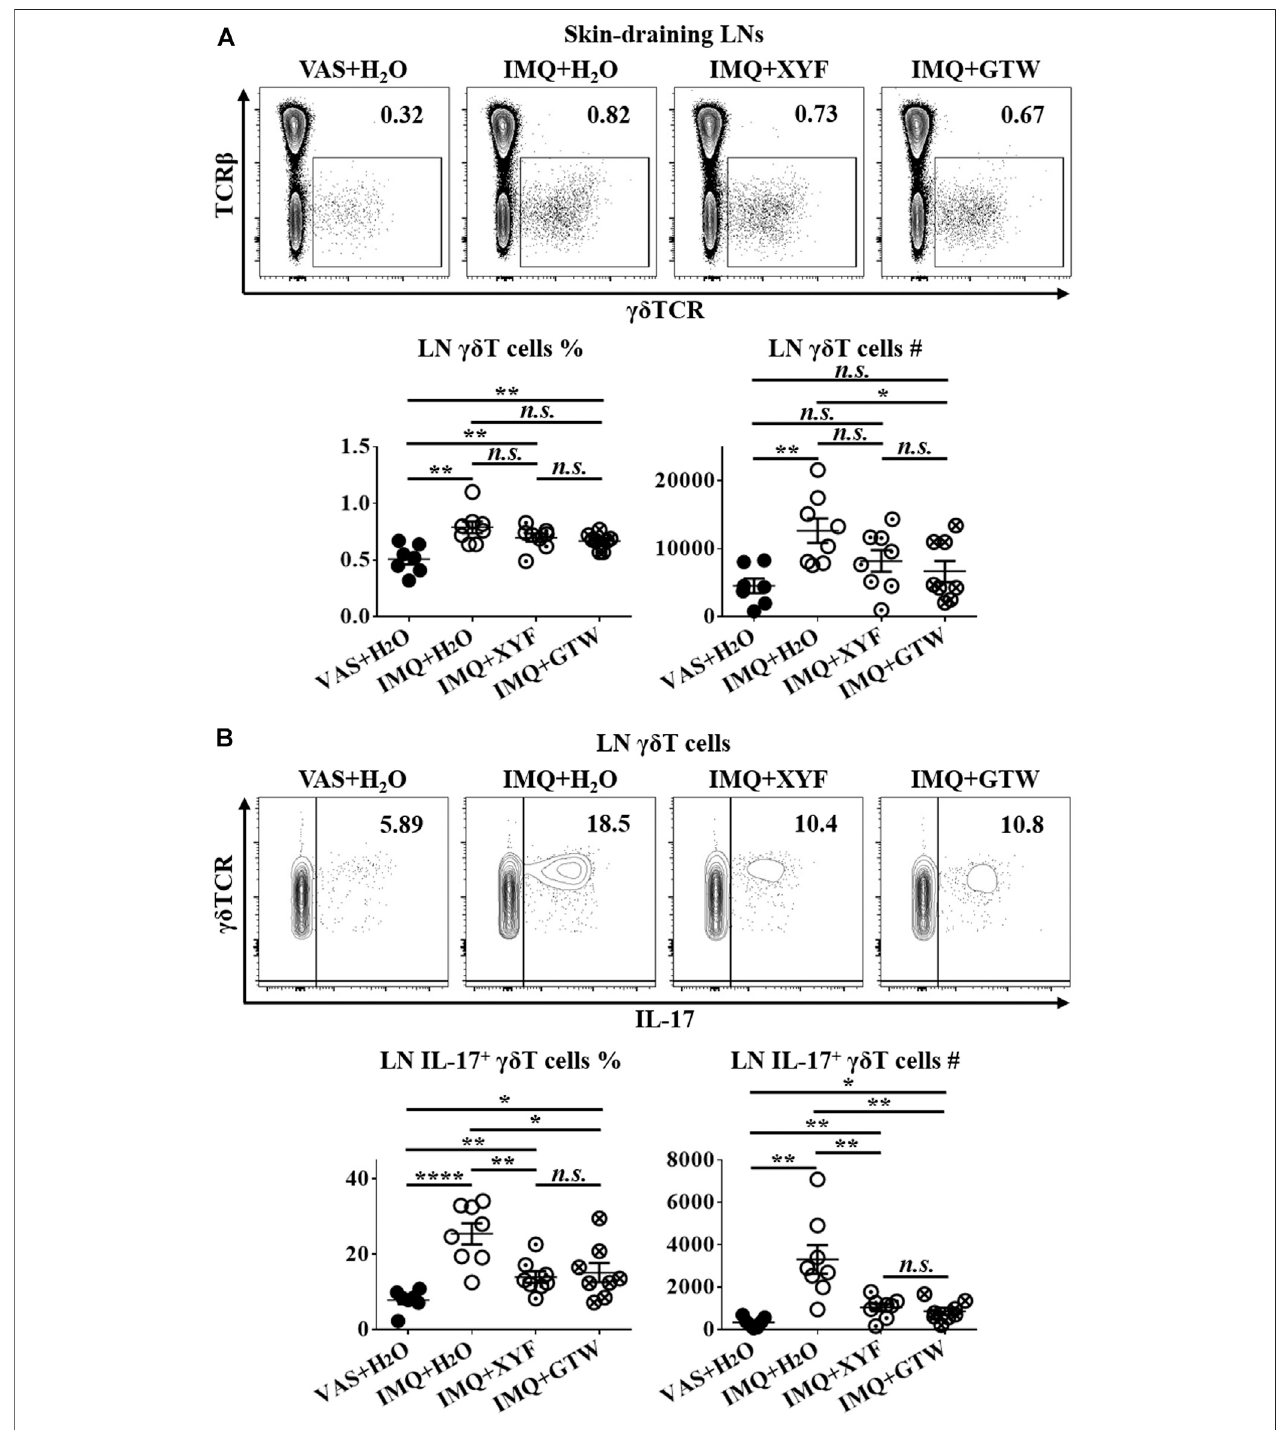
FIGURE 3 | Xiao-Yin-Fang therapy prevented lymphnode γ δ T cell secretion of IL-17. Mice were treated as in Figure 2 . Skin-draining axillary, brachial and inguinal lymphnodes(LN)wereharvestedonday10.FreshlyisolatedLNcellswere invitro culturedinthepresenceofPMA,ionomycinandBrefeldinAfor4 h.LNcellswerethen stained with anti-CD45, TCR β , γ δ TCR, CD11b, and IL-17 antibodies, which were analyzed by fl ow cytometry. Representative scatter plots, the ratios, and numbers of LN γ δ T cells (A) and IL-17 + γ δ T cells (B) . n (cid:2) 31, three independent experiments. The data were presented as mean ± s.e.m.